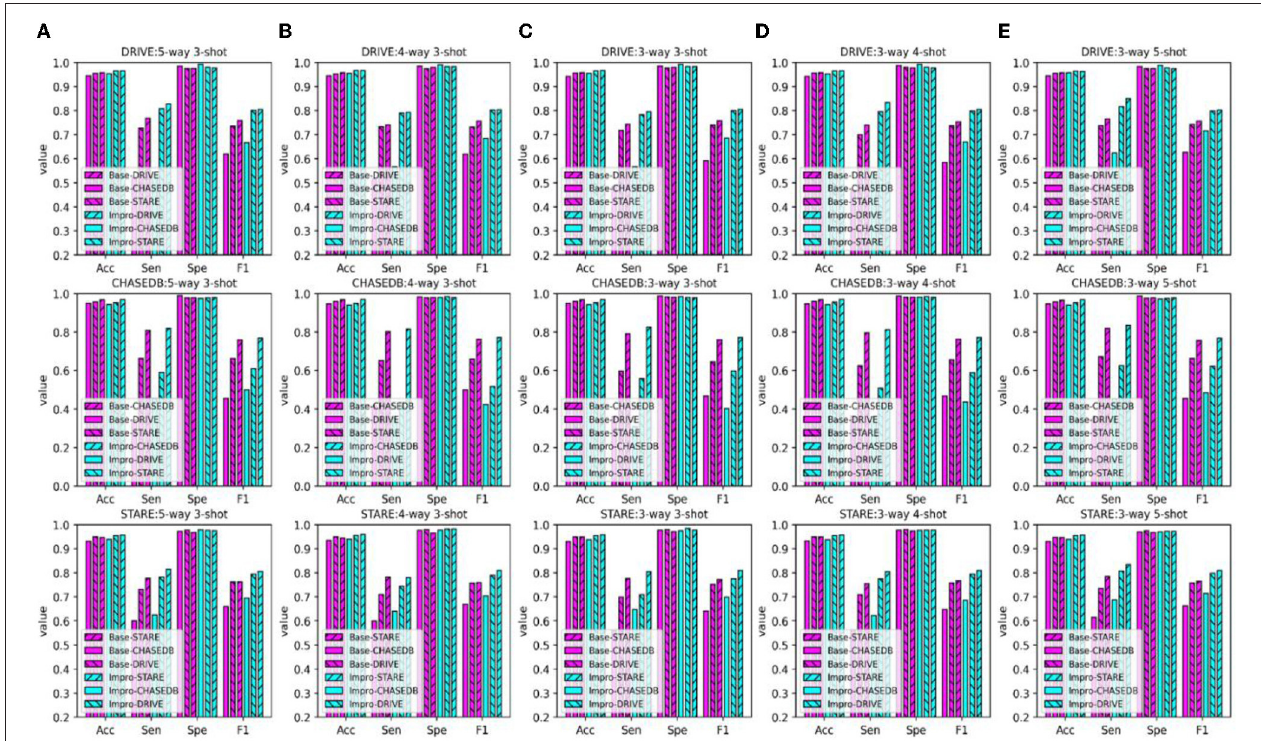
FIGURE 10 | Comparison of the domain adaptability based on the Acc, Sen, Spe, and F1: (A) 5-way 3-shot; (B) 4-way 3-shot; (C) 3-way 3-shot; (D) 3-way 4-shot; and (E) 3-way